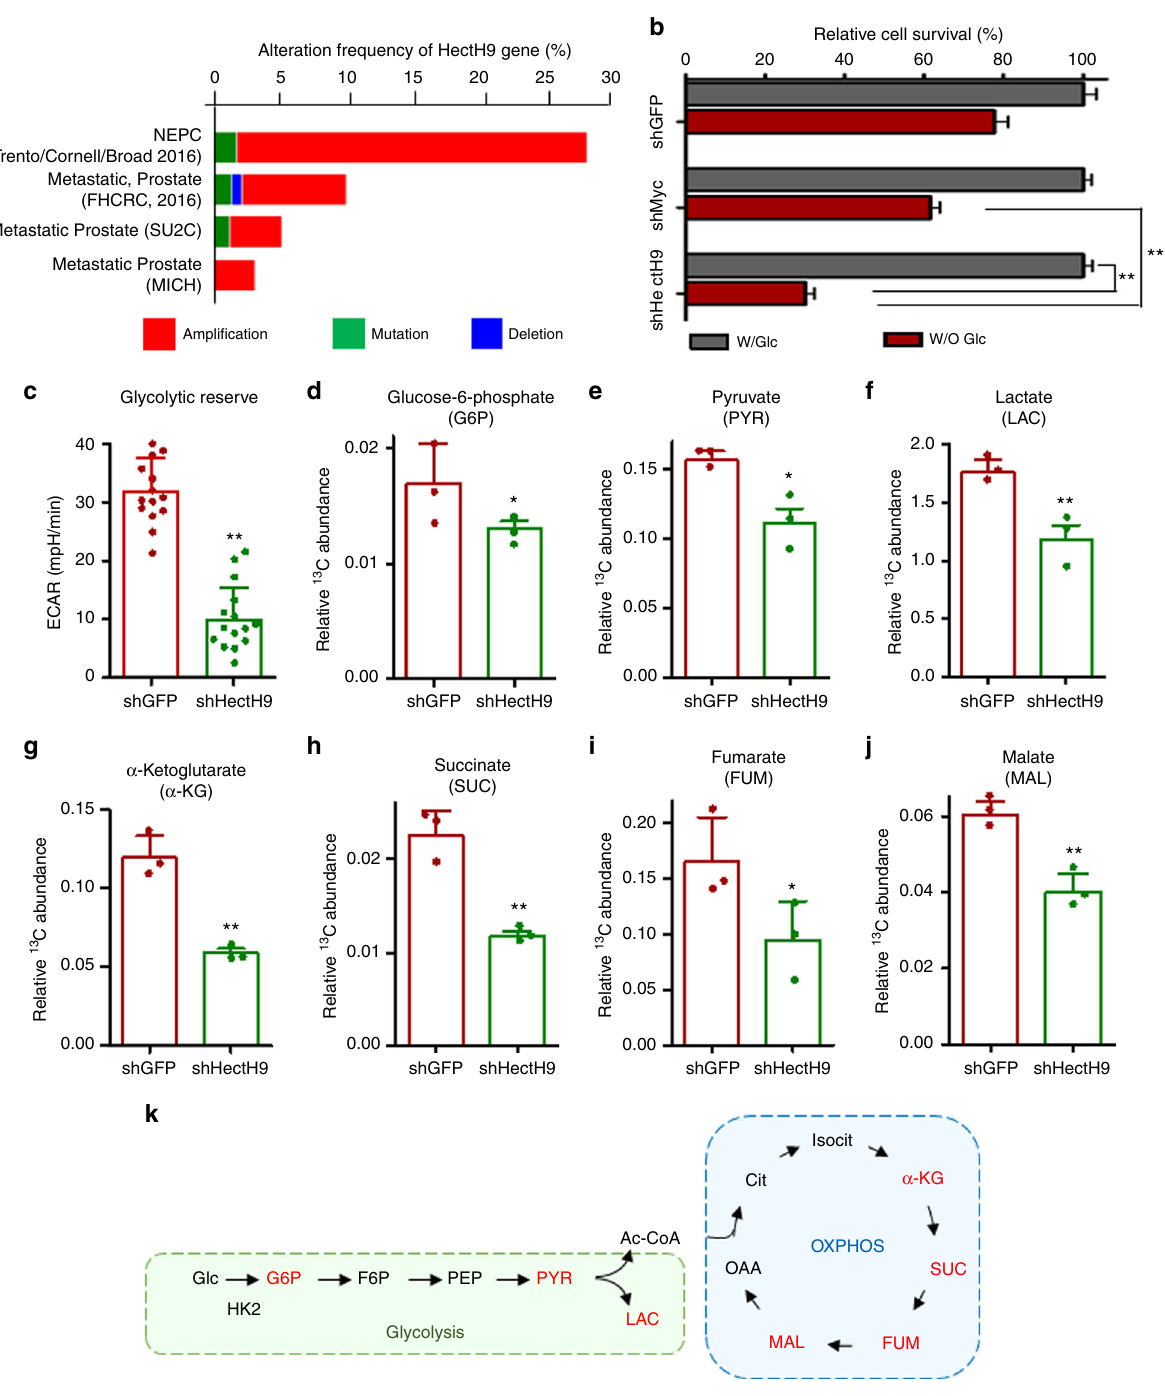
Fig. 1 Tumor-associated HectH9 is a novel regulator of glucose metabolism. a cBioportal was used to access TCGA data for HectH9 ( Huwe1 ) gene alteration from four different studies of human prostate cancer. Frequencies of HectH9 gene ampli fi cation are shown in red. ( b ) Cell viability assay in PC-3 cells stably infected with lentiviruses expressing shRNA targeting GFP, Myc or HectH9 in glucose-containing and -deprived medium ( n = 3). c The extracellular acidi fi cation rate (ECAR), was measured by using a Seahorse Bioanalyzer in PC-3 cells infected with lentiviruses expressing shRNA targeting GFP or HectH9 ( n = 15). d – j Relative abundance of 13 C-labeled glucose-6-phosphate ( d ), pyruvate ( e ), lactate ( f ), α -ketoglutarate ( g ), succinate ( h ), fumarate ( i ) and malate ( j ) were determined by GC-MS in PC-3 cells infected with lentiviruses expressing shRNA targeting GFP or HectH9 ( n = 3). Results in b – j are presented as mean value ± SD; * p < 0.05, ** p < 0.01, by Student ’ s t -test. Experiments were performed at least twice. k Schematic illustration depicts the metabolic changes (labeled in red) in glycolysis pathway and oxidative phosphorylation (OXPHOS) regulated by